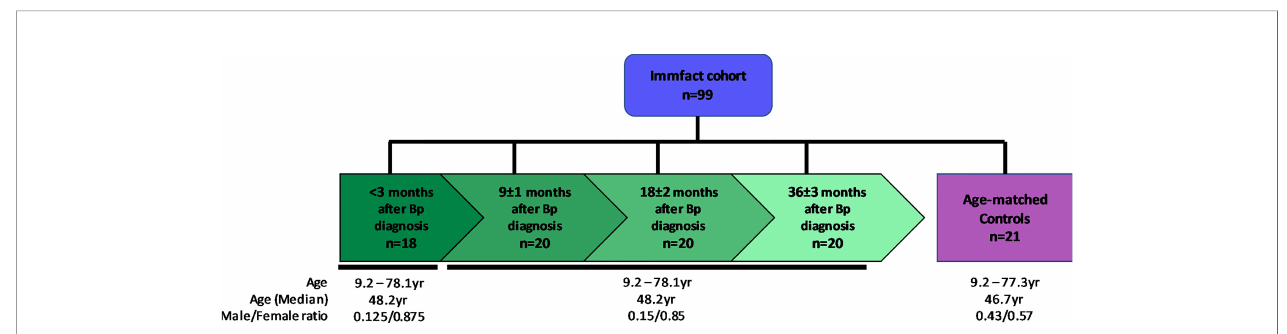
FIGURE 1 | Schematic representation of the study population. Shown are the number (n) of serum samples in the convalescent pertussis ex-patients group (green) which were sampled in a longitudinal fashion at <3, 9, 18 and 36 months after diagnosis as well as that of the age matched control group (purple). Age median and range in years as well as male/female ratio are shown per sample